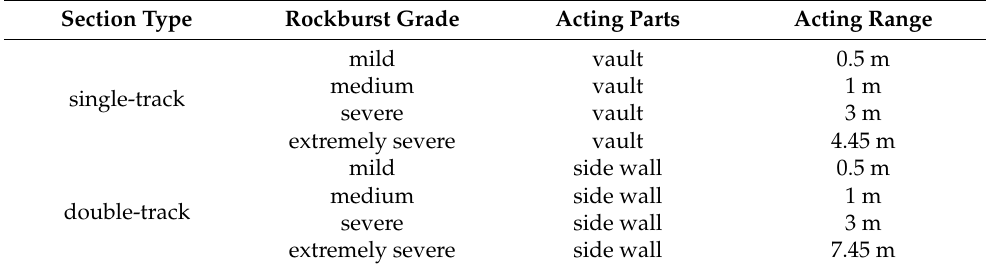
Table 11. Parts and range of impact